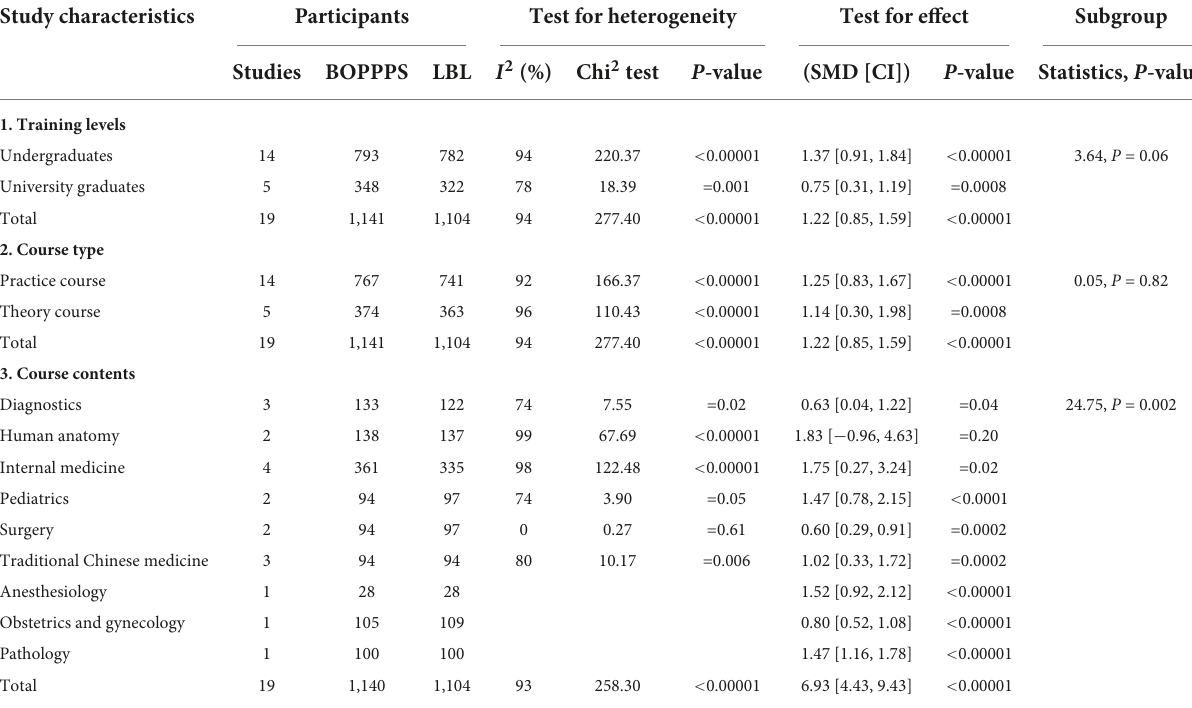
TABLE 3 Subgroup analyses of comprehensive ability scores in this